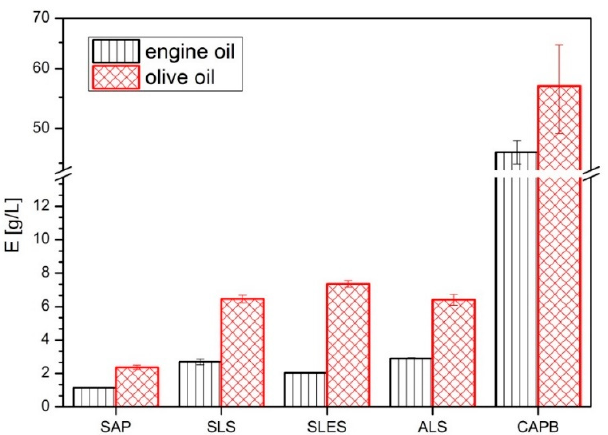
Figure 5. Oil emulsification capacity (E) of the soapwort extract (SAP) and synthetic surfactants (SLS, SLES, ALS, CAPB) towards the olive and engine oils, defined as a maximum weight of oil that can be emulsified in 1 L of 1% (bio)surfactant solution at room temperature.